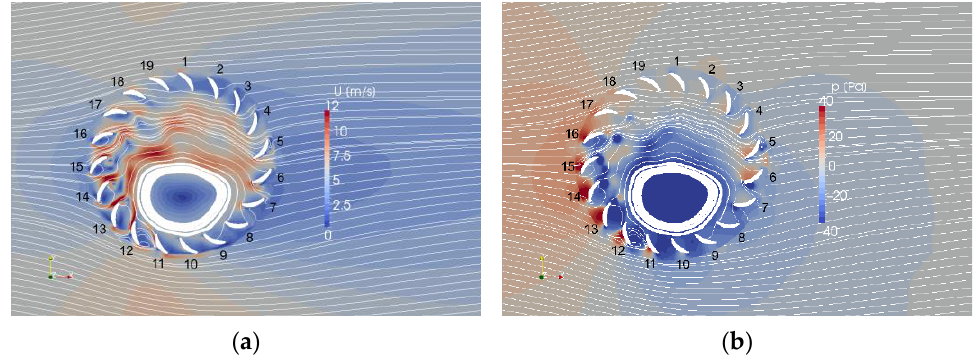
Figure 14. Velocity and pressure distribution and streamlines in case of the bare cross-flow wind turbine with no flow deflector, ( a ) velocity distribution, U ; ( b ) pressure distribution, p .